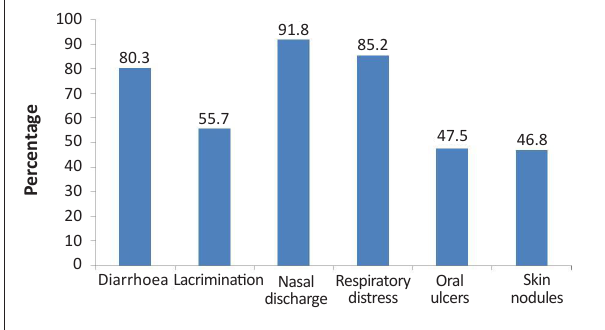
FIGURE 4: Clinical signs presented by Peste des Petits Ruminants